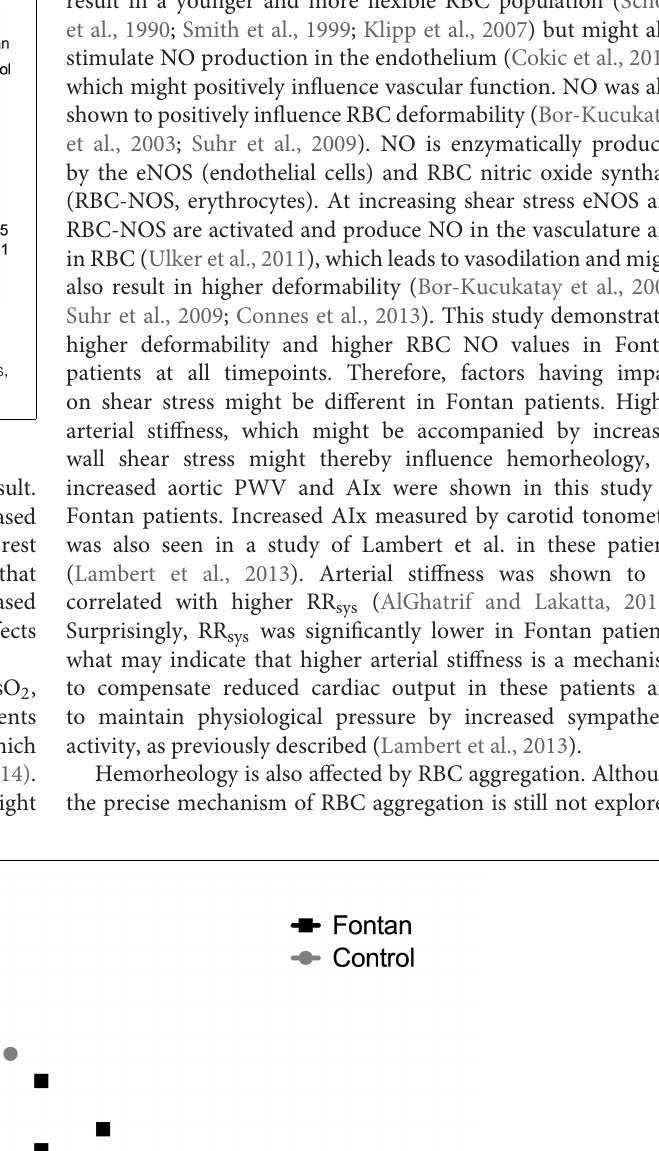
Frontiers in Physiology |